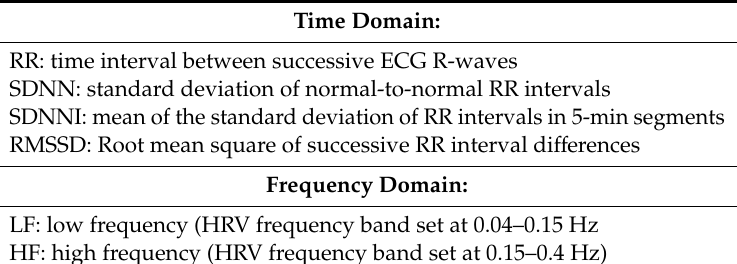
Table 1. Heart rate variability